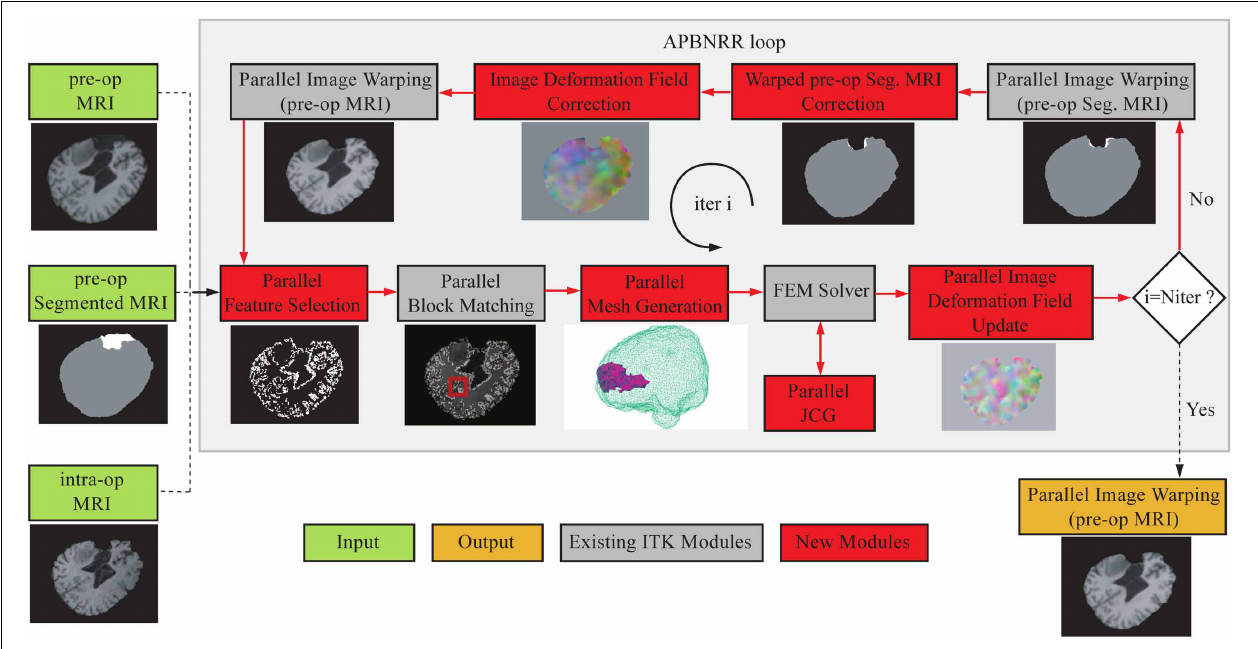
FIGURE 1 | The APBNRR framework. The red boxes represent the new contributions and the gray boxes the existing ITK modules. The red arrows show the execution order of the different modules. The